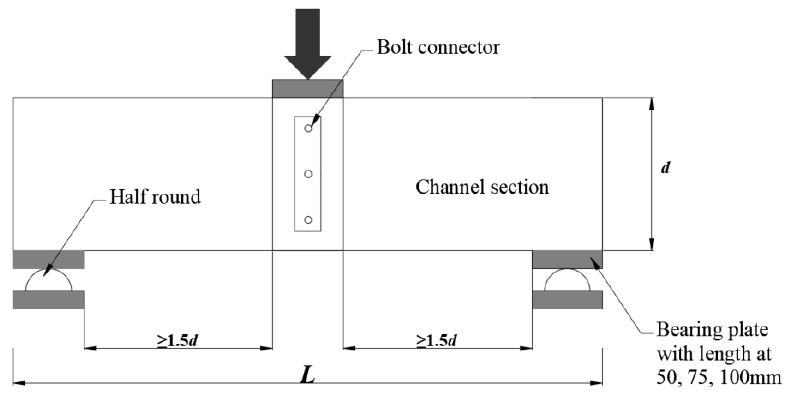
Figure 3. Test configuration